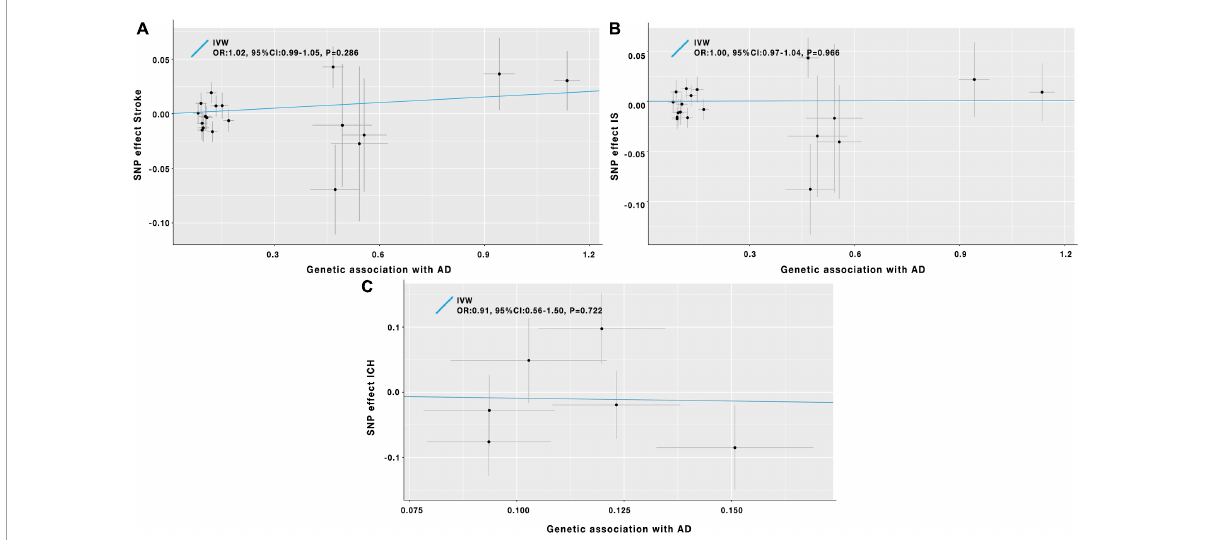
FIGURE2 Scatter plot of the causal effects of AD on the risk of stroke (A) , IS (B) , and ICH (C) . IV, instrumental variable; IVW, inverse-variance-weighted; SNP, single-nucleotide polymorphism; OR, odds ratio; CI, confidence interval; AD, Alzheimer’s disease; IS, ischemic stroke; ICH, intracerebral